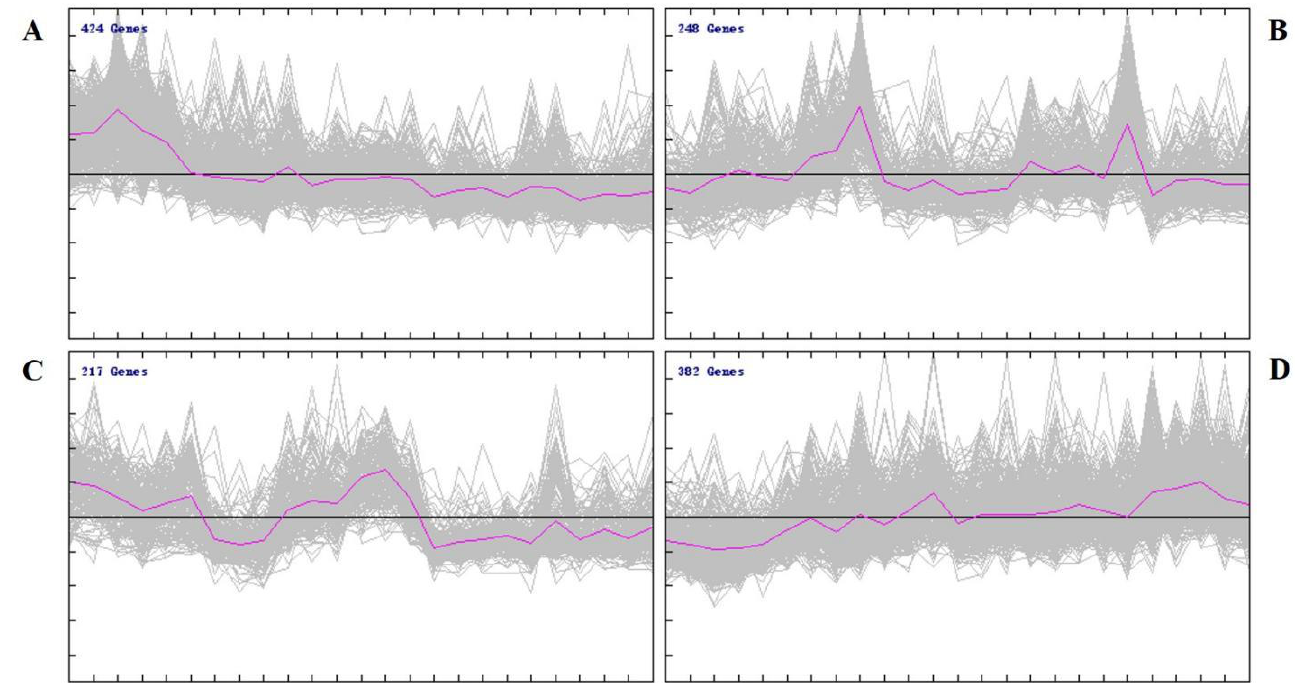
Figure 2. Expression trends of DEGs ( A ) Cluster 1 of DEGs between different groups. The DEGs expression levels decreased with age in the Laiwu black goat. ( B ) Cluster 2 of DEGs between different groups. A high expression of DEGs in the W2 and W8 groups and a low expression in the other groups. ( C ) Cluster 3 of DEGs between different groups. A high expression of DEG in the D1 and W4 groups and an upregulation of the low expression in the other groups. ( D ) Cluster 4 of DEGs between different groups. The DEGs expression levels increased with